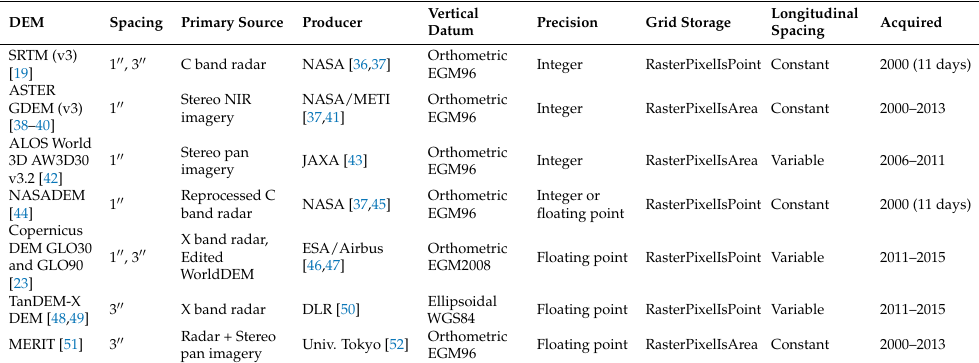
Table 1. Free Quasi-global DEMs at 1 and 3 arc second